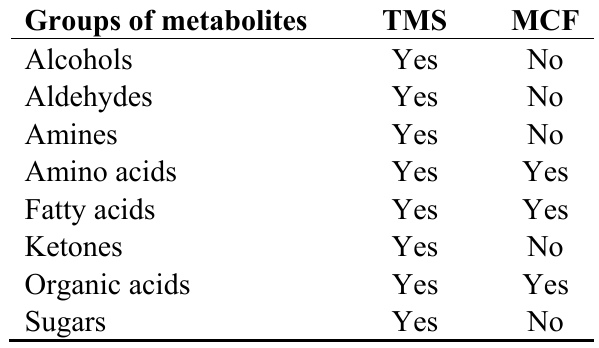
Table 3. Summary of group of metabolites detected by TMS and MCF.